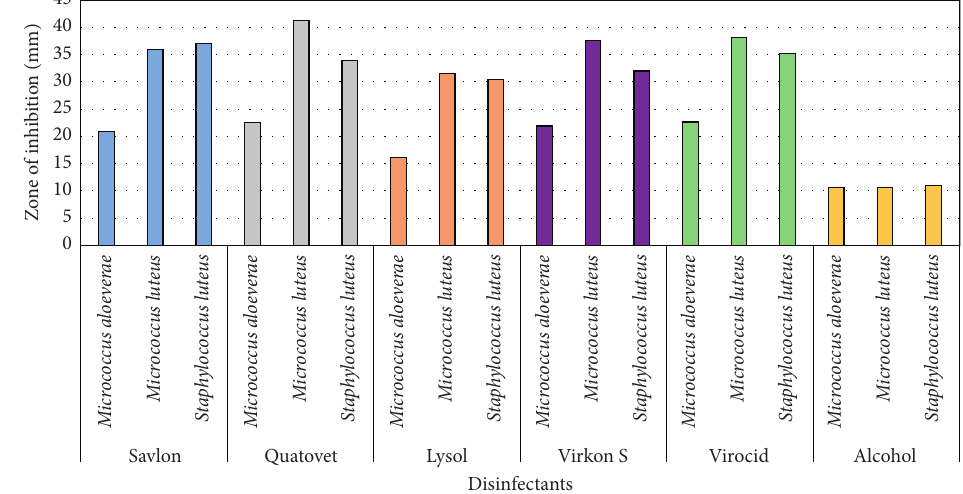
Figure 3: Diagrammatic representation of in vitro efficacy of disinfectants (100% conc.) against Gram-positive bacteria. Y axis represents the diameter of inhibition zone (mm). Here, blue, gray, pink, violet, green, and yellow indicate Savlon, Quatovet, Lysol, Virkon, S. Virocid, and alcohol,